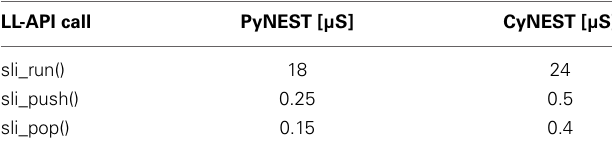
Table 1 | Comparison of execution timings of low-level API primitives in PyNEST and